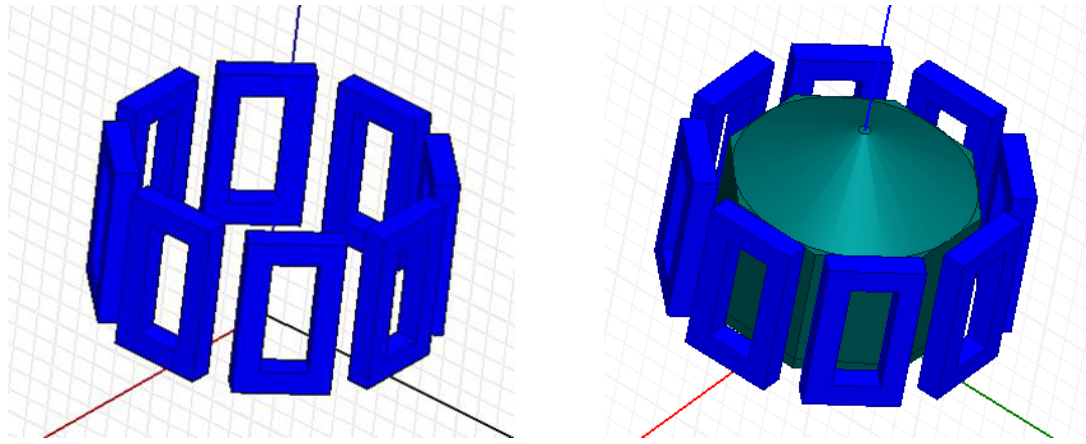
Figure 1. Arrangement of single stage acceleration coils without and with